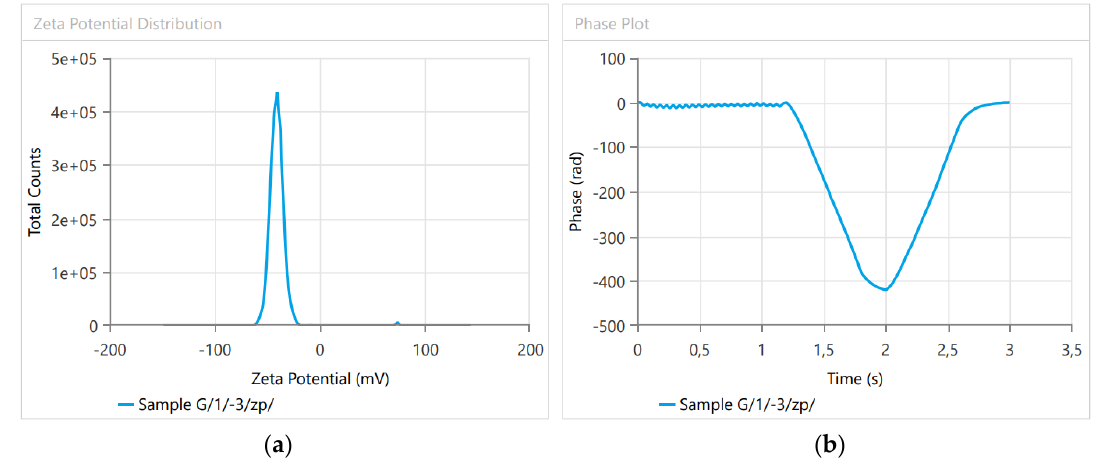
Figure 3. Determination of the Zeta potential based on the electrophoretic mobility of liposomes. ( a ) Zeta potential distribution: the colloid stability is proven to be high, showing the Zeta potential between − 40.66 and − 40.53 mV. ( b ) Phase plot to estimate the electrophoretic mobility of particles: Phase difference is proportional to the electrophoretic mobility of the nanomaterial and, thus to the Zeta potential of the aqueous medium.